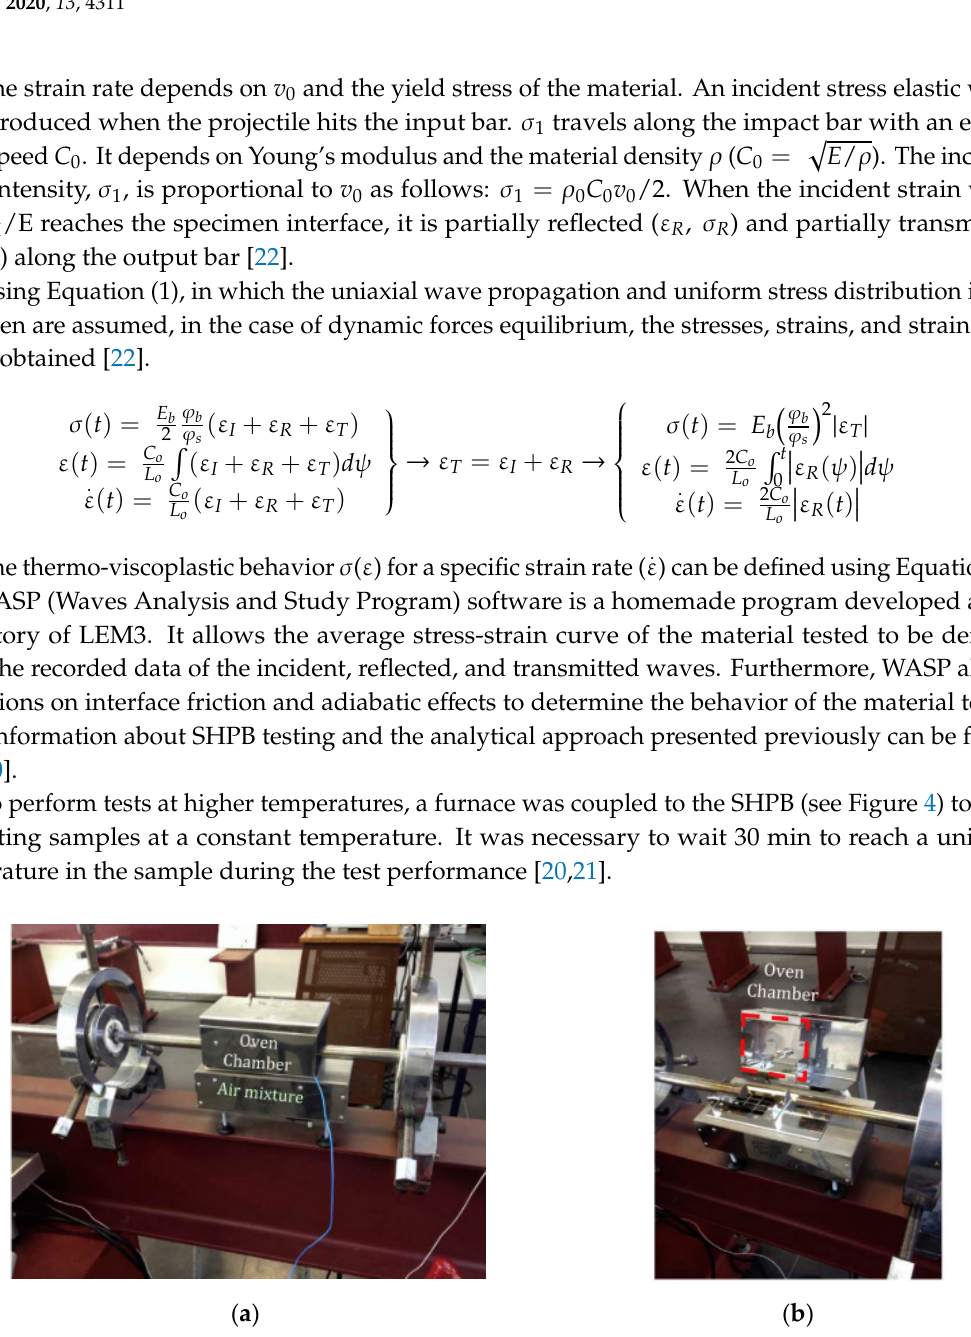
Figure 4. Furnace used in compression machine: ( a ) closed furnace; ( b ) open furnace [23].